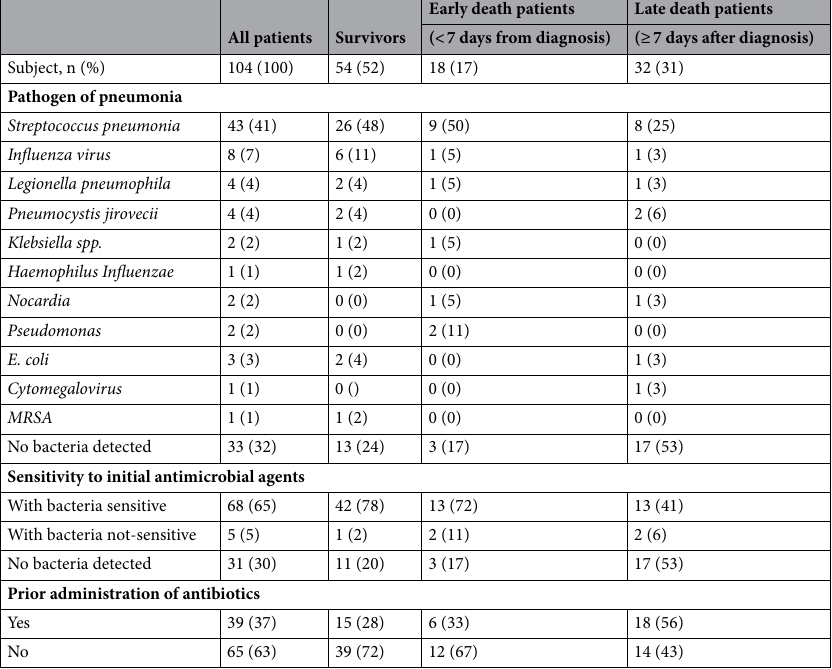
Table 2. Microbiological etiology and use of antipathogen agents. Spp species, MRSA methicillin-resistant Staphylococcus